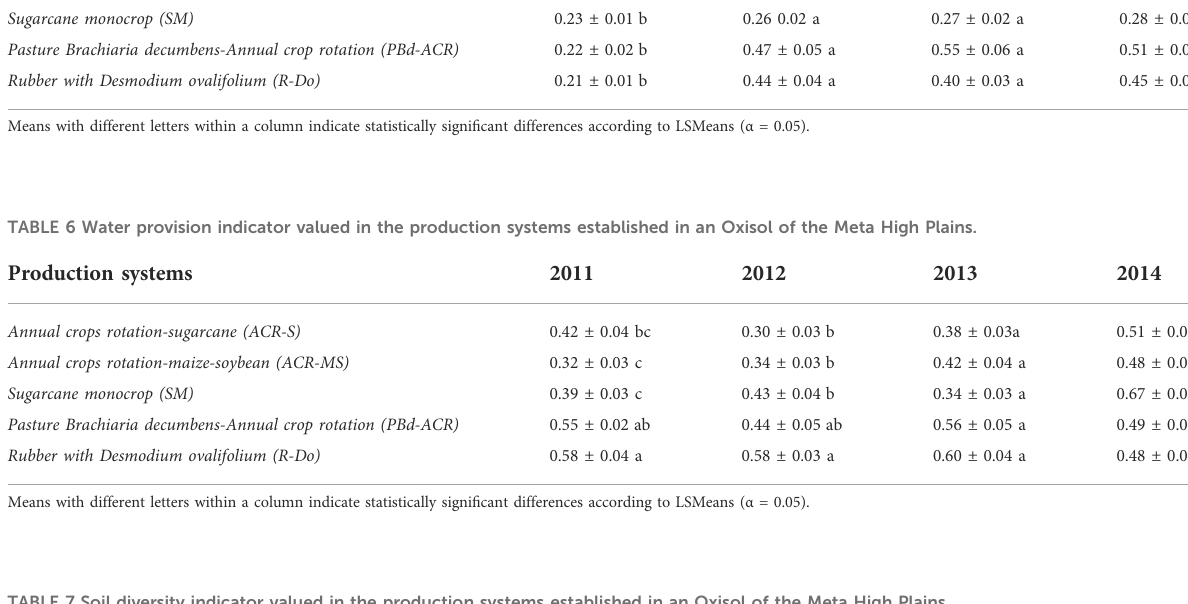
TABLE 7 Soil diversity indicator valued in the production systems established in an Oxisol of the Meta High